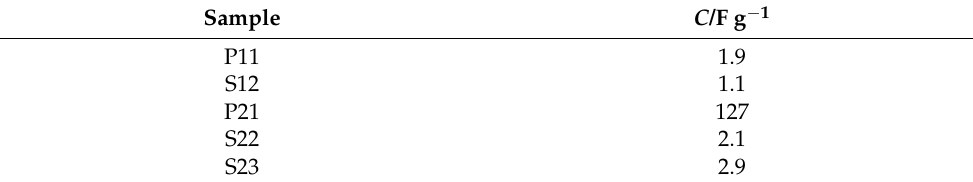
Figure 4. Cyclic voltammograms of P21 in KOH and H 2 SO 4 solution at different potential scan rates. Table 6. Gravimetric capacitances of prepared CFs in 1.8 M TEMA BF4 in PC solution.